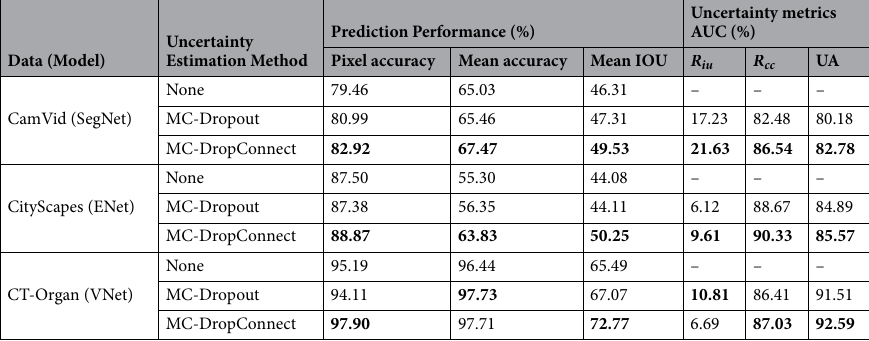
Table 2. Quantitative prediction and uncertainty estimation performance of the various frameworks on the CamVid, CityScapes, and CT-Organ datasets. Our quantitative analyses support the superior performance of the MC-DropConnect in terms of both segmentation accuracy and uncertainty estimation quality. The models with the best performances are shown in bold.